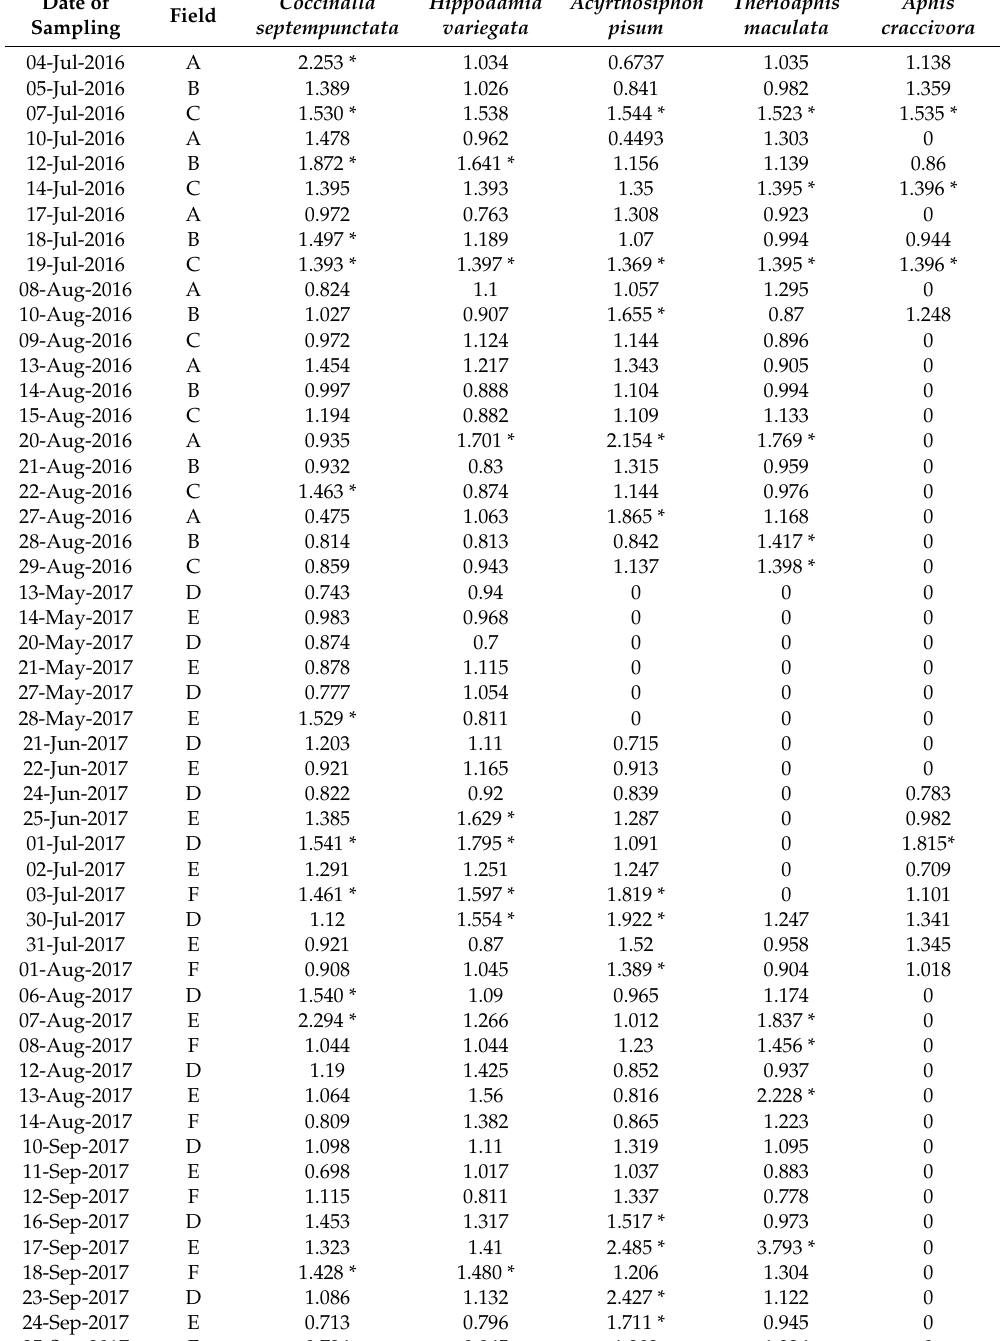
Table 3. Index of aggregation of coccinellids and aphids in alfalfa